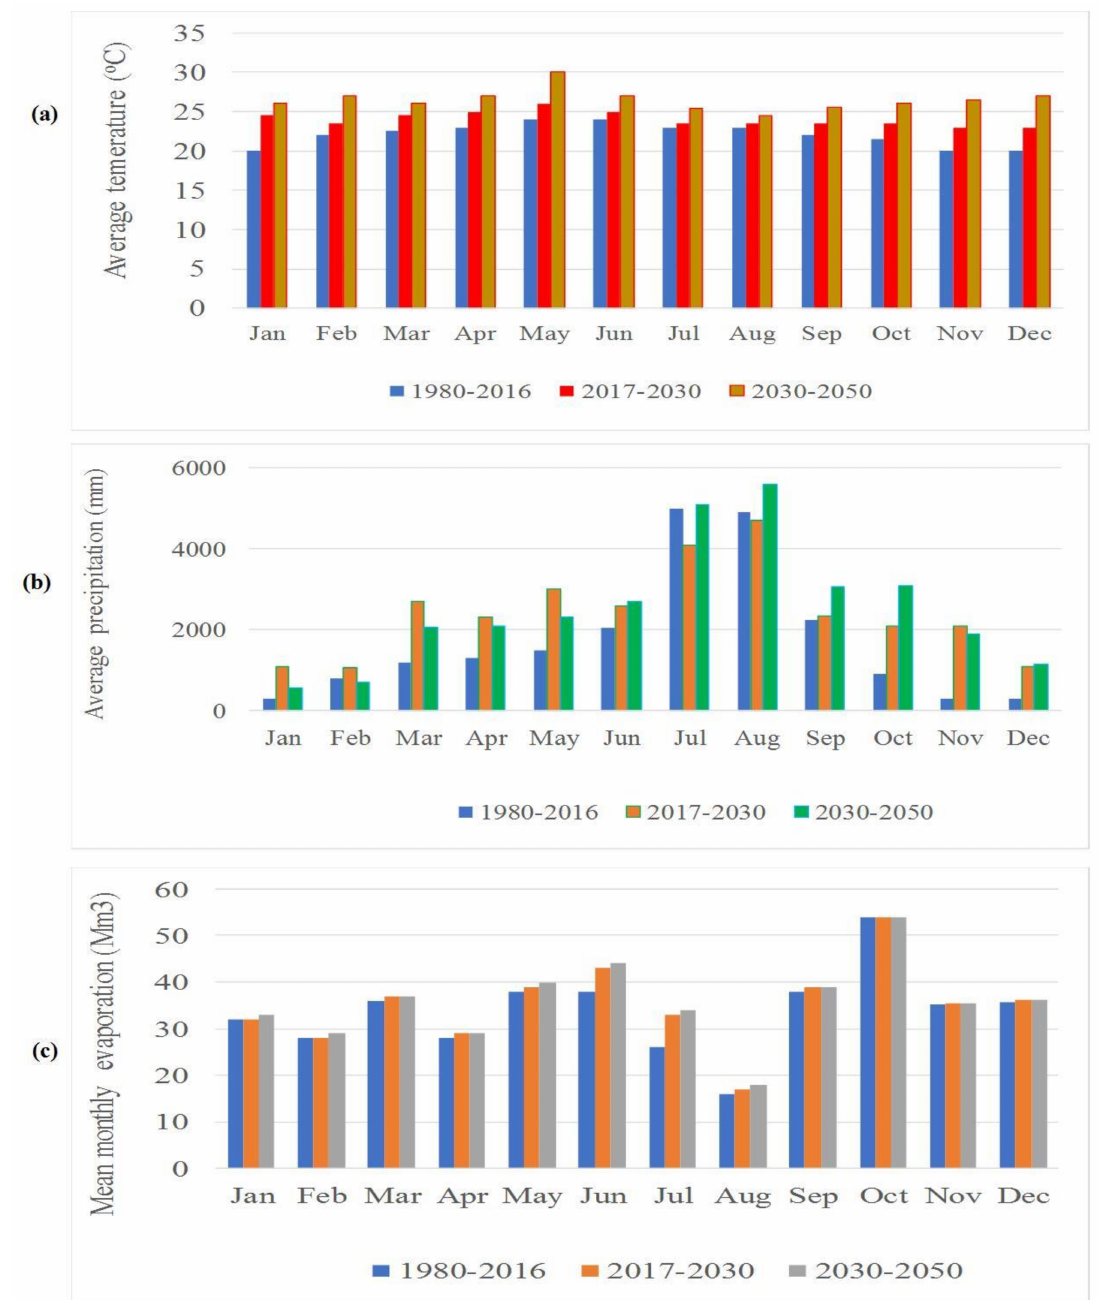
Figure 6. Average monthly temperature, precipitation, and evaporation under the three scenarios. ( a ) Average temperature, ( b ) average precipitation, and ( c ) mean monthly